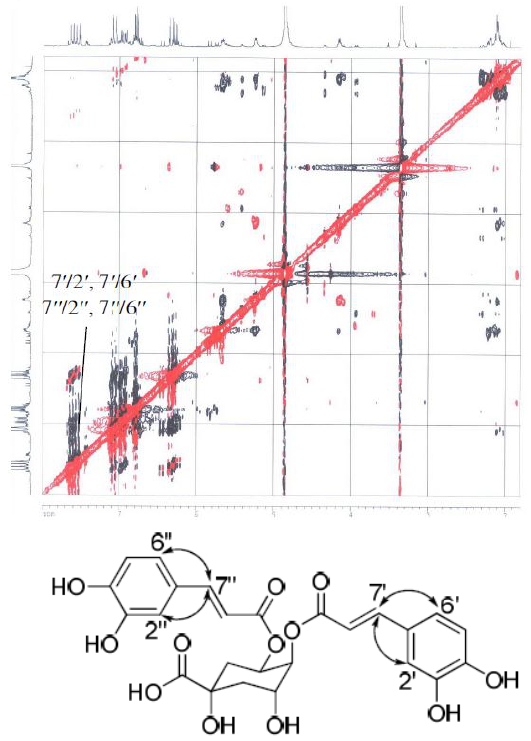
Figure 5. ROESY spectrum of compound